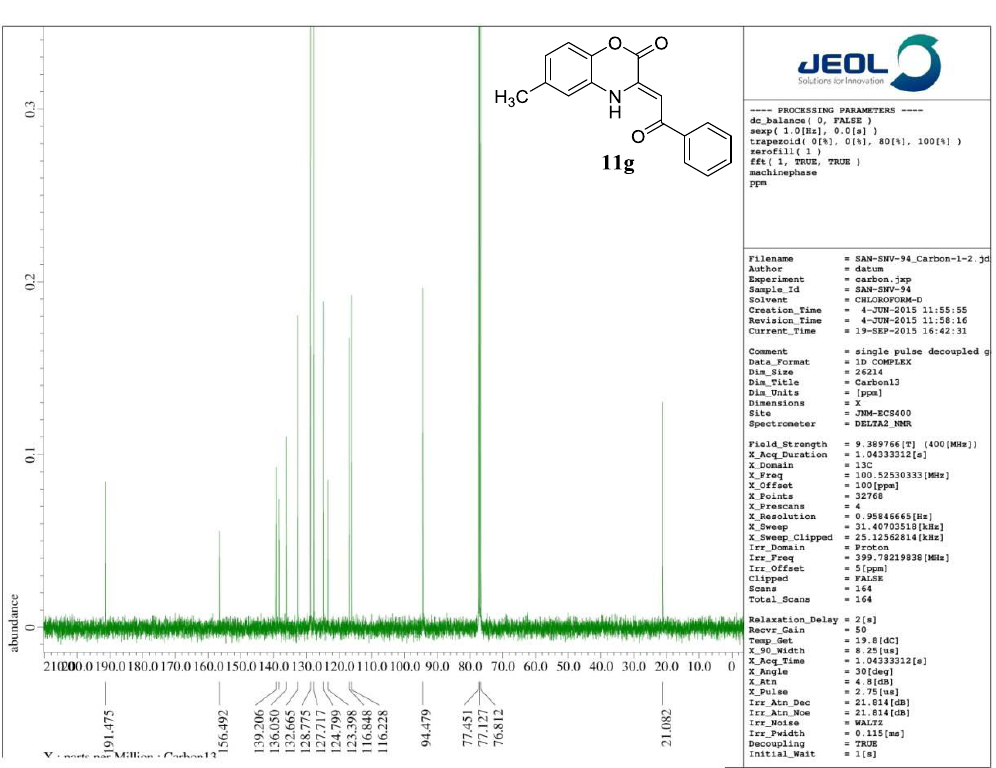
Figure 14. 13 C NMR Spectra of Compound 11g